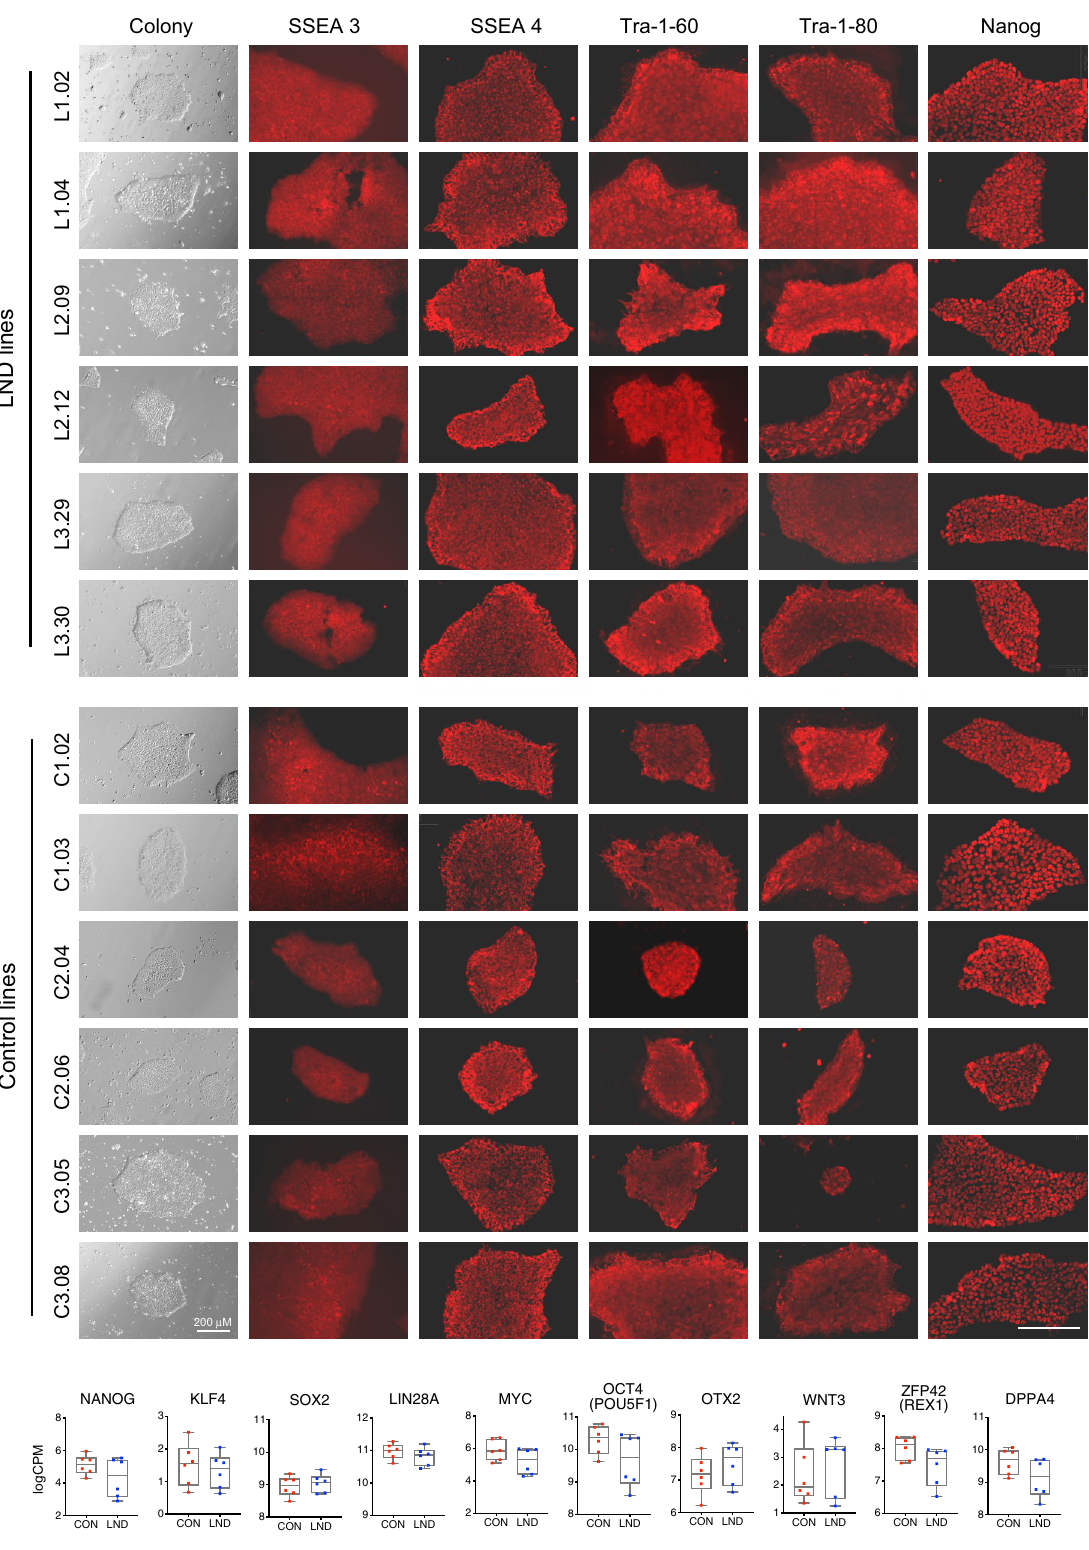
Figure 1. Pluripotency characteristics. This figure shows a phase-contrast photomicrograph of typical colonies for all 6 LND and all 6 control lines, along with immunostains for pluripotency markers (SSEA3, SSEA4, TRA- 1-60, TRA-1-80, Nanog). All cultures were stained simultaneously, and all photomicrographs were taken using the same microscope settings. Scale bar is shown at bottom right and depicts 200 μM. Gene expression profiling shown as box plots at the bottom of the figure reveal that the control and LND lines expressed similar levels of genes associated with